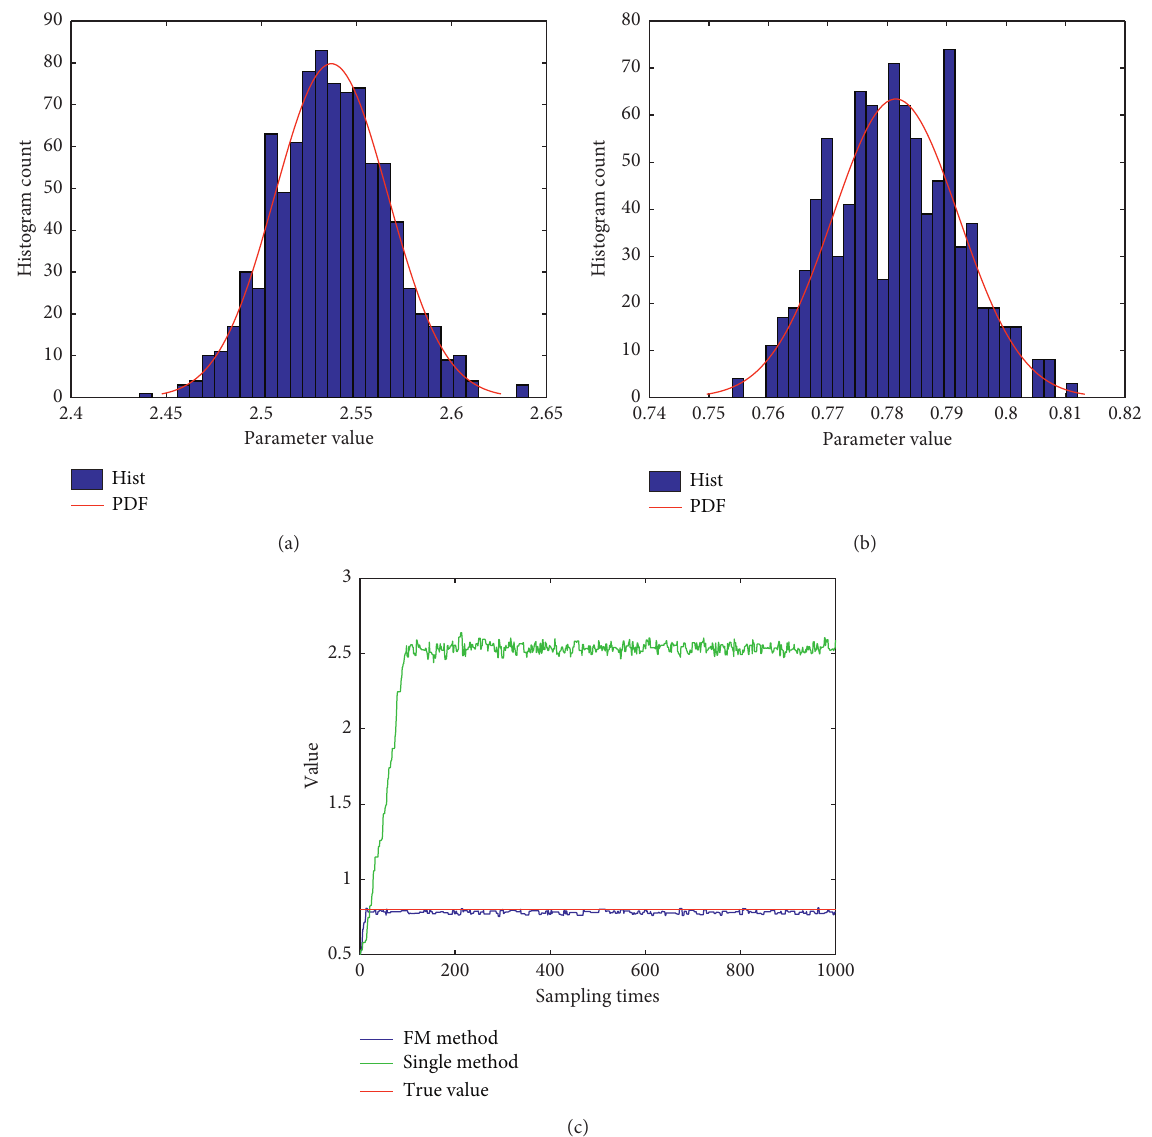
Figure 6: Case study 3: (a) single method, (b) FM method, and (c) sampling